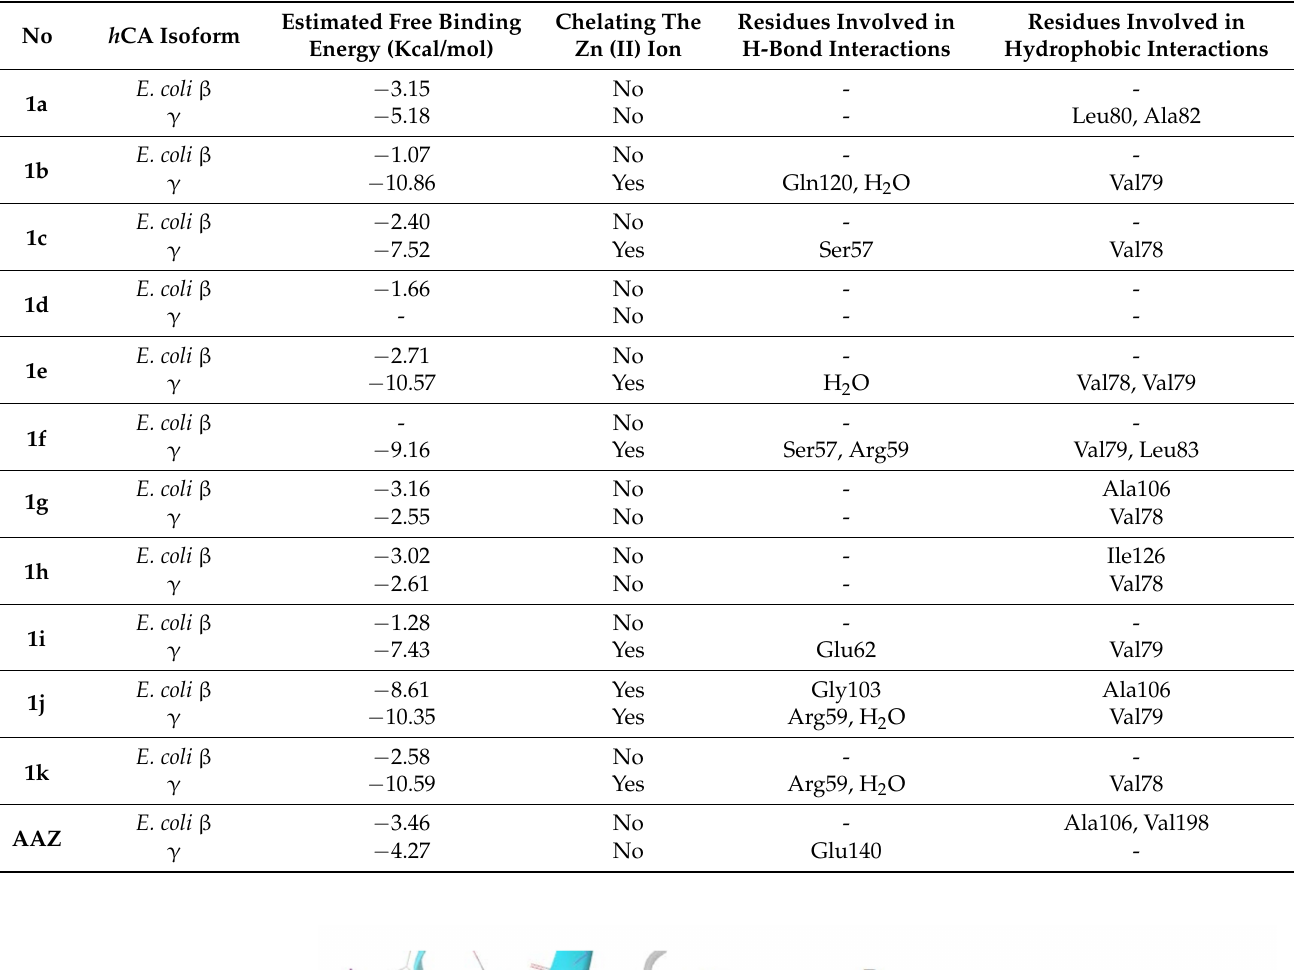
Table 5. Molecular docking free binding energies (kcal/mol) and interactions of tested compounds on β - and γ -CA classes.